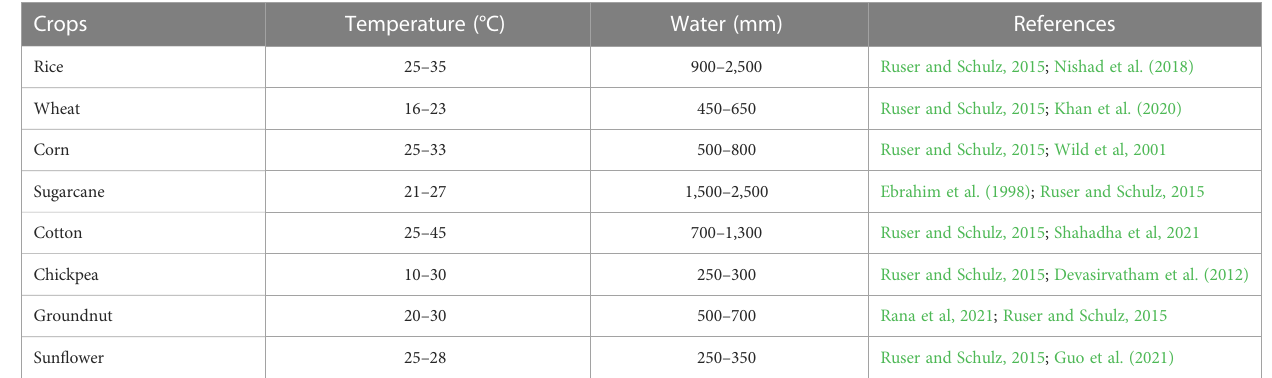
TABLE 3 Temperature and water requirement of major